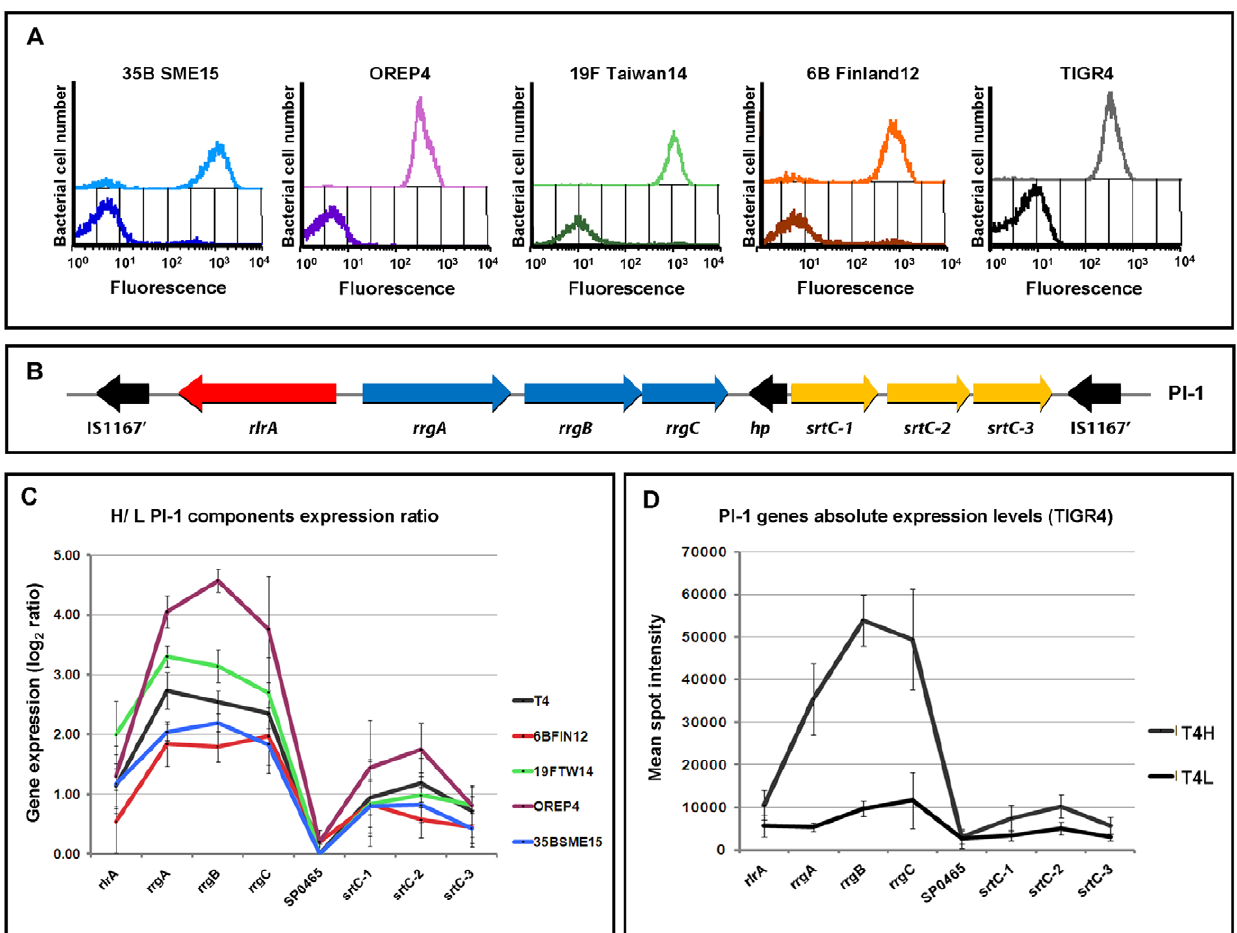
Figure 5. Pilus-1 expression is regulated at the transcriptional level. A) High and low pilus expressing sub-populations of strains TIGR4 (Clade I), 19F Taiwan 14 (Clade I), OREP4 (Clade I), 6B Finland 14 (Clade II) and 35B SME 15 (Clade III) were labeled with clade specific anti-RrgB antibodies (1:400 dilution) and FITC anti-mouse IgG secondary antibodies (1:100 dilution). Pilus-1 expression was then analyzed by flow cytometry (FACS-Calibur). B) Schematic representation of PI-1. C) Log 2 ratio values indicating the PI-1 genes differential expression in High vs. Low pilus expressing sub-populations in the five above mentioned strains, as measured by spotted DNA microarray analysis. The data are measures of relative gene expression during in vitro growth in liquid cultures. The values reported for each gene are the mean of all the spots and their replicates within the array and of two independent experiments (bars represent standard deviations). D) Absolute gene expression levels of PI-1 genes measured for TIGR4 high and low pilus expressing sub-populations by microarray hybridization. Absolute expression levels reported for each gene are the mean of all the spots and their replicates within the array and of two independent experiments (bars represent the obtained standard deviations).